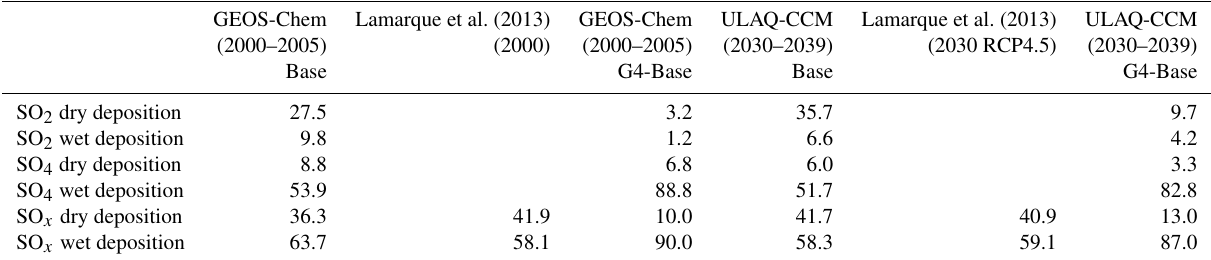
Table 4. Breakdown of global SO x deposition fluxes (percent).